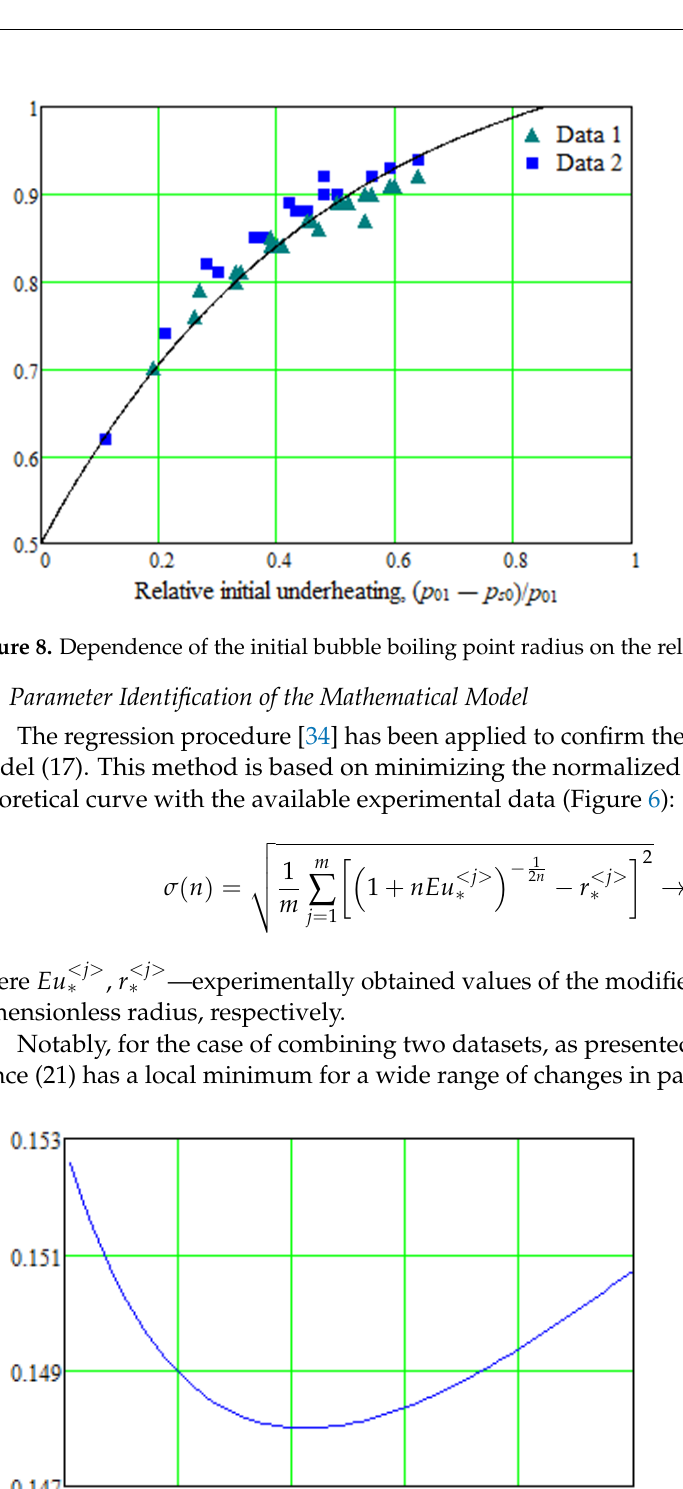
15 of 21 Figure 6. Dependence of the dimensionless radius on the modified Euler number.